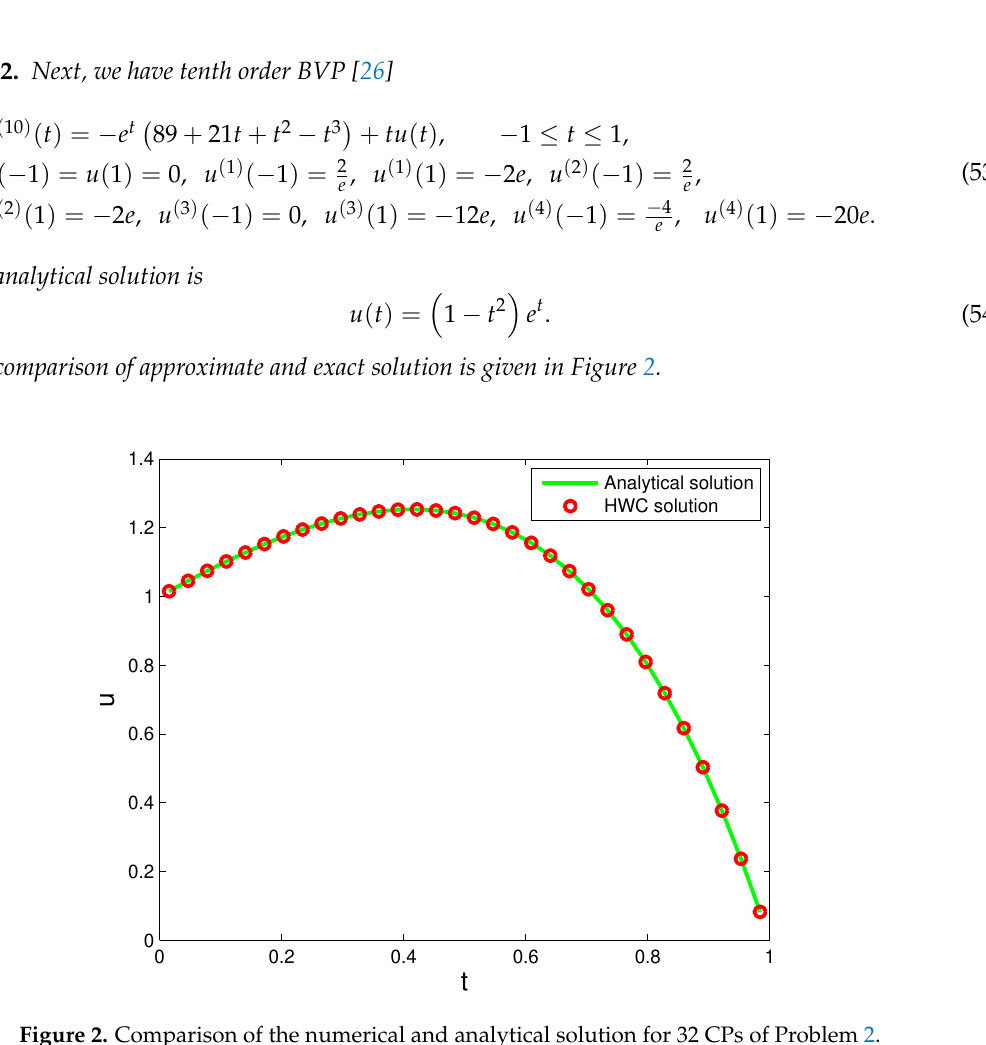
Figure 2. Comparison of the numerical and analytical solution for 32 CPs of Problem 2.